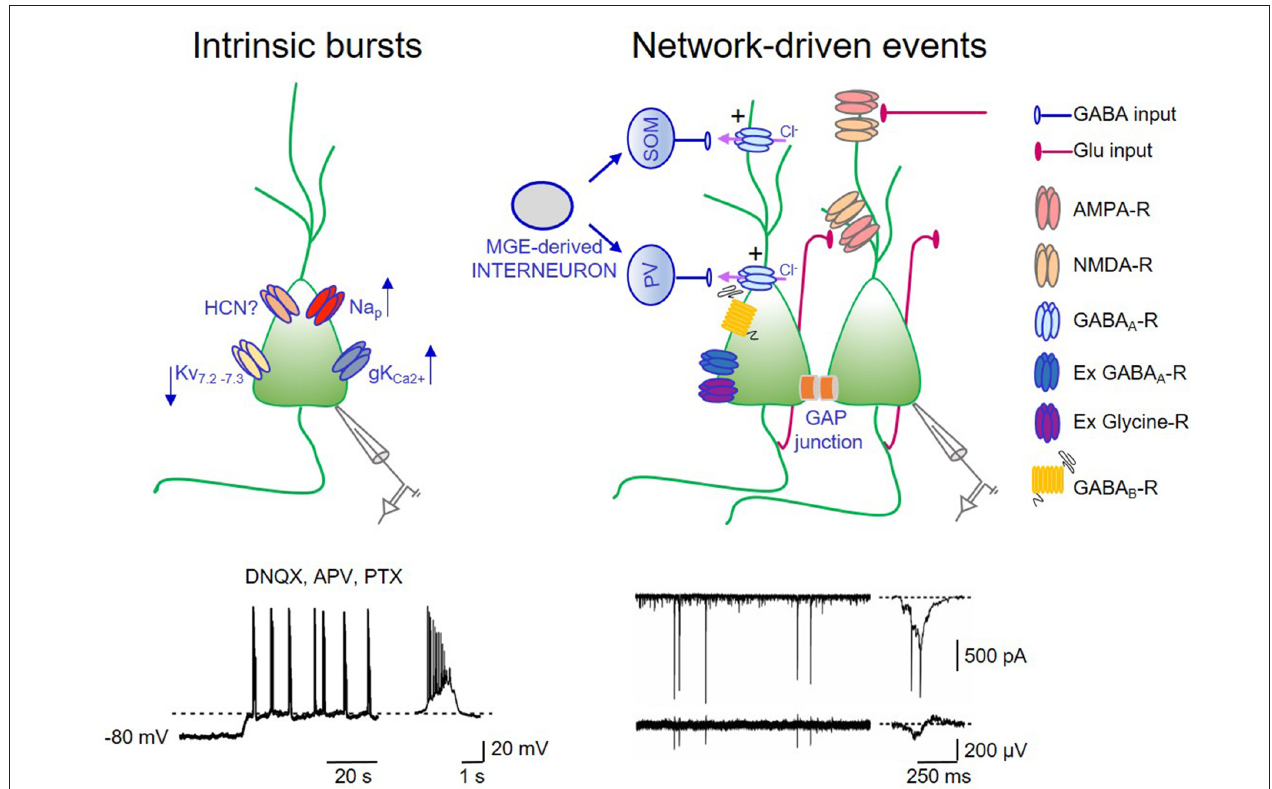
FIGURE 1 | Intrinsic bursts exert a permissive role in giant depolarizing potentials (GDPs) generation. On the left: schematic drawing of a pyramidal cell endowed with some of the ionic channels contributing to up- and down regulate intrinsic bursts. Na p : voltage-dependent sodium channel mediating persistent sodium current (I-Nap); Kv7.2–7.3: potassium channel responsible for I M ; hyperpolarization-activated cyclic nucleotide (HCN)-gated channel mediating I h ; gKCa 2 + : calcium dependent potassium channel mediating the slow after hyperpolarization. In the trace below: whole cell patch clamp recording (in current clamp configuration) from a P3 CA3 principal cell, in the presence of DNQX, APV, PTX to block synaptic transmission. A membrane depolarization from − 80 mV to the voltage window where Na p channels are activated (dashed line) triggers bursting activity (a single burst shown on the right in an expanded time scale). Intrinsic bursts are facilitated by the low expression of I M . The pacemaking role of I h in bursting activity is unclear (see text). Calcium rise during repeated action potentials within the burst open calcium-dependent potassium channels responsible for bursts termination. On the right: schematic drawing of the local hippocampal circuit responsible for GDPs. Medial ganglionic eminence (MGE) derived interneurons (gray) give rise to somatostatin (SOM) and parvalbumin (PV)-positive interneurons (blue) innervating the distal and proximal dendrites of pyramidal cells, respectively. CA3 principal cells (green) are connected via recurrent collaterals (red) and through gap junctions. They receive also glutamatergic inputs from entorhinal cortex (EC) and from the controlateral hippocampus (red). At this developmental stage, the majority of GABAergic synaptic contacts on principal cells and interneurons are depolarizing and excitatory (+) because of the outwardly directed flux of chloride ions. Gap junctions favor network synchronization and GDPs occurrence. In addition, GDPs are modulated by extrasynaptic GABA A and glycine receptors. Activation of GABA B receptors by massive release of GABA during GDPs, together with the activation of calcium-dependent potassium channels are responsible for GDPs termination. Below: whole cell patch clamp recording (in voltage clamp configuration) of network-driven events (GDPs) from a P5 CA3 principal cell (upper trace) and associated local field potentials (bottom trace). These events are shown on the right in an expanded time